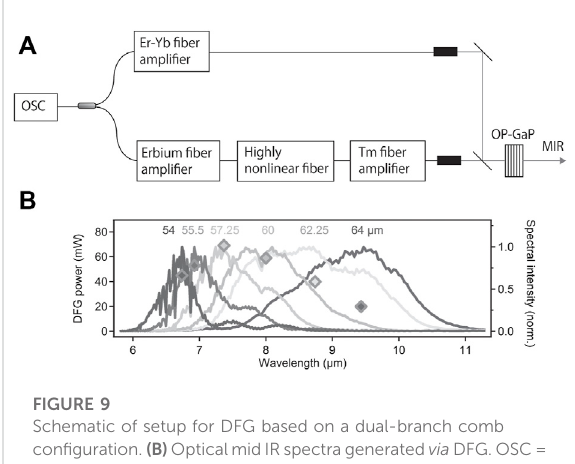
FIGURE 9 Schematic of setup for DFG based on a dual-branch comb con fi guration. (B) OpticalmidIRspectragenerated via DFG.OSC= oscillator, OPGaP = orientation-patterned gallium phosphide, MIR = mid-infrared